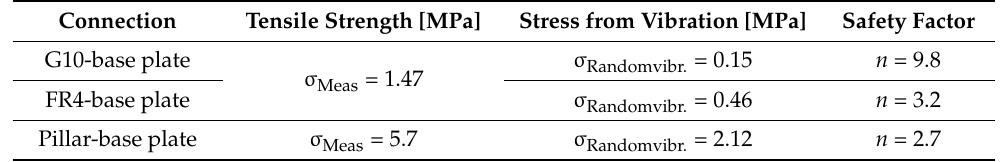
Table 7. The comparison of the results from tensile test and the vibration simulation. Connection Tensile Strength [MPa] Stress from Vibration [MPa] Safety Factor σ G10-base plate Randomvibr. = 0.15 n = 9.8 σ Meas = 1.47 FR4-base plate σ Randomvibr. = 0.46 n = 3.2 Pillar-base plate σ Meas = 5.7 σ Randomvibr. = 2.12 n =